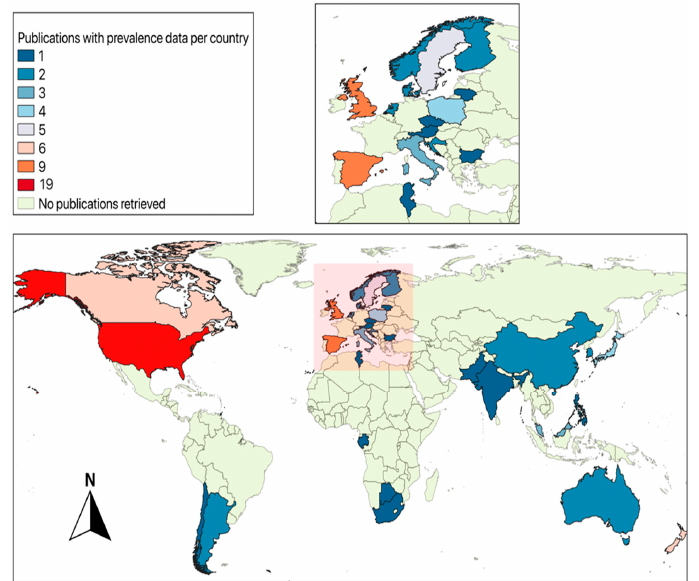
Figure 1. Global map (made it with QGIS 3.4 software [149]) representing the number of publications with Campylobacter prevalence in wildlife per country. The number of publications per country are color-coded as per the index and the top left of the fi gure. The area shaded in the box at the bo tt om of the fi gure is shown in more detail in the top right corner of the fi gure due to the close geographical proximity of many of the European nations in which papers on the topic have been published.